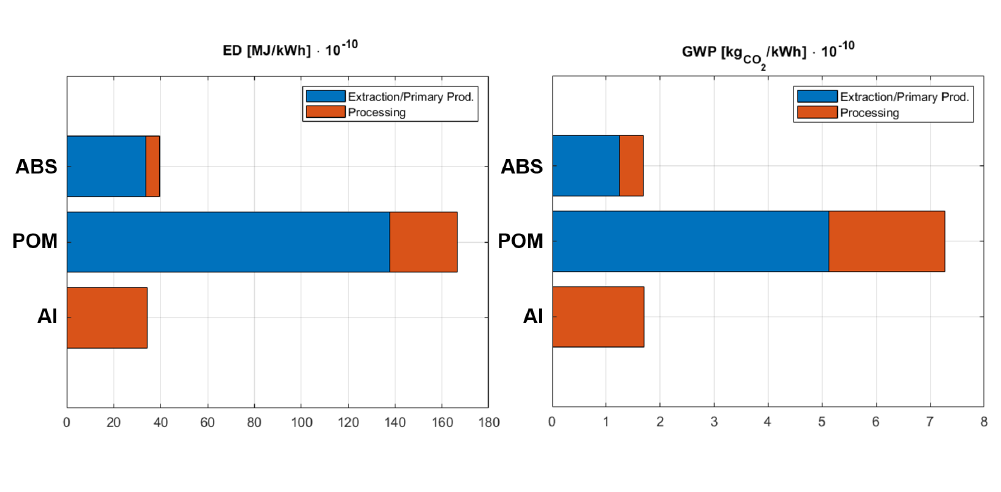
Figure 5. Average ED and GWP per unit of energy related to the ABS, POM, and aluminum extraction and primary production